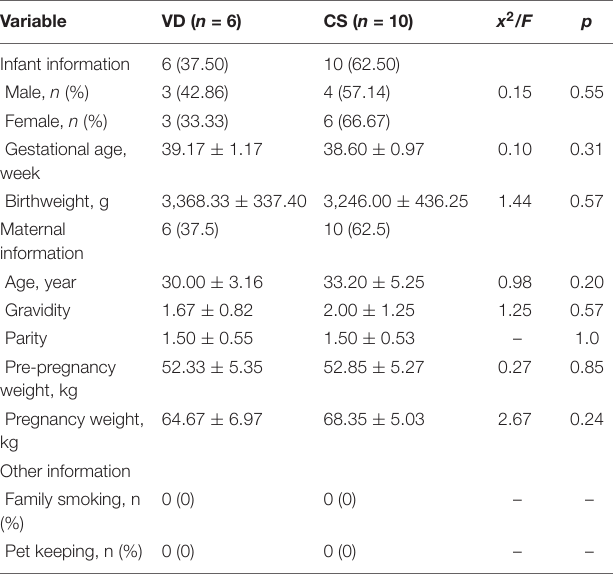
TABLE 1 | General characteristics of infants enrolled in the study according to delivery